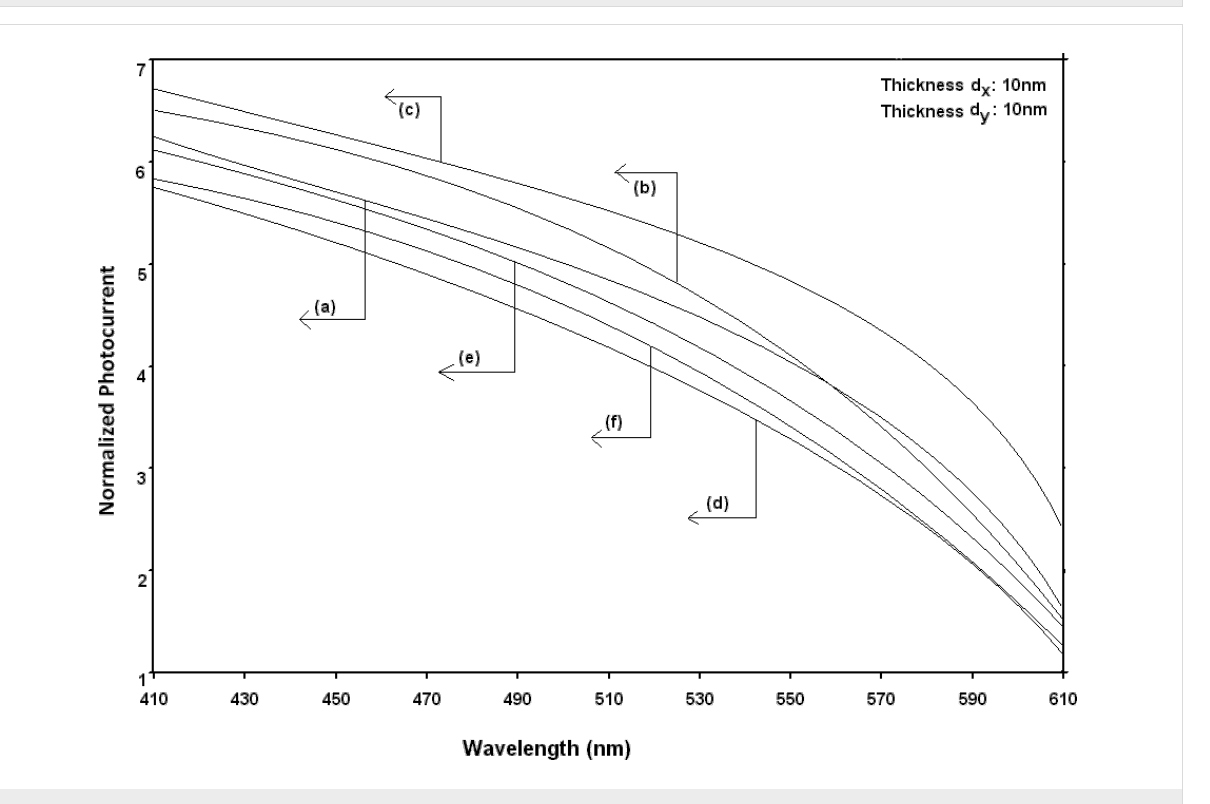
Figure 8: Plot of the normalized photocurrent from quantum well wire effective mass superlattices of HgTe/Hg 1 − x Cd x Te and In x Ga 1 − x As/InP as a function of normalized intensity for all cases of Figure 6.